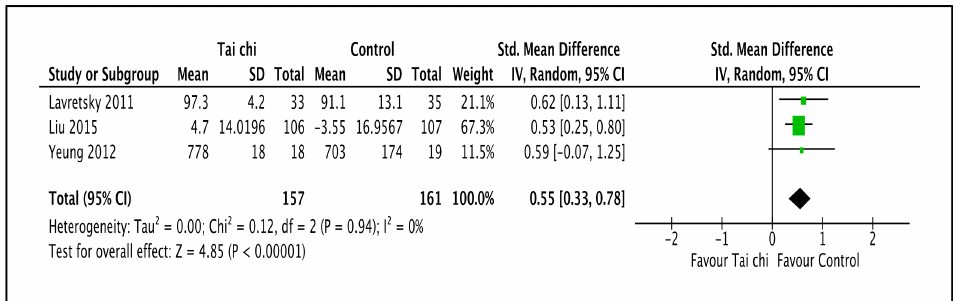
Figure 7. Forest plot shown for comparison of the combinations of Tai Chi and antidepressants versus standard antidepressants for physically related QOL outcome [44,49,50]. Note: Line indicates confi- dence interval and the green square indicates effect estimate. Black diamond indicates cumulative effect and its confidence interval. Comparison 2: Tai Chi versus no